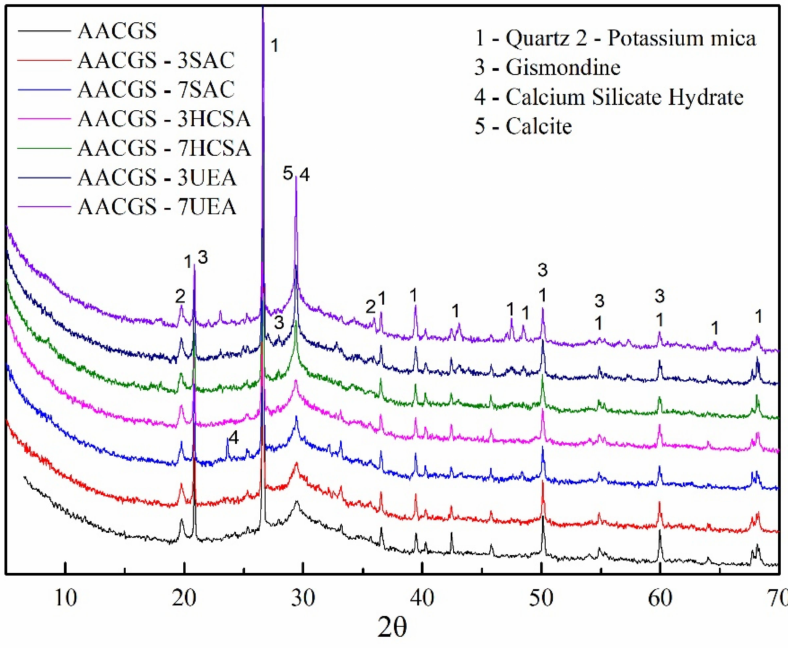
Figure 4. XRD pattern of AACGS mixture with mineral admixture in 28